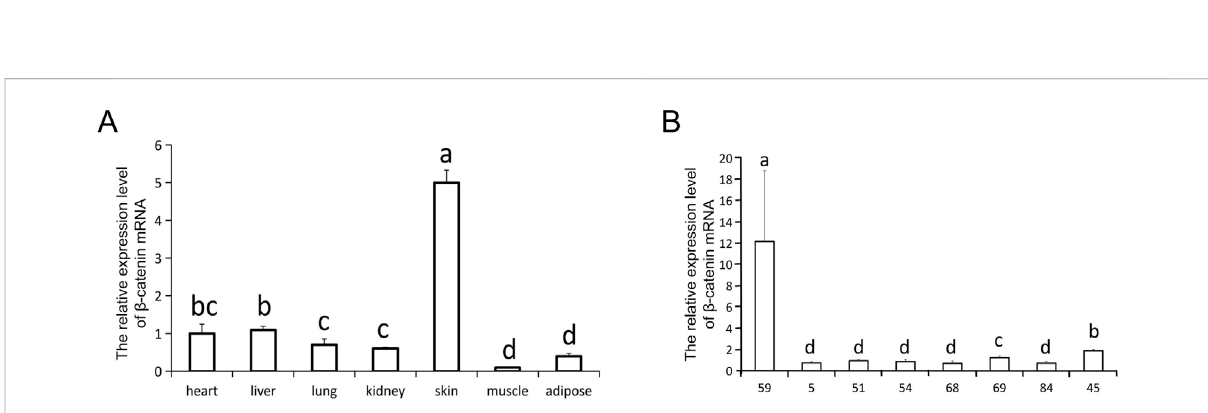
FIGURE 2 The relative expression level of β -catenin mRNA. (A) The expression of β -catenin mRNA in skin of different transgenic mouse lines (F0). 45 is a wilde-type control line. (B) qRT-PCR analysis of the β -catenin mRNA expression in different tissues of line 59 (F0). The relative quantity of β -catenin mRNA in (A) and (B) were determined via qRT-PCR using 2 − ΔΔ CT method, with GAPDH as the internal control. Each experimental group contained threereplicatesandqRT-PCRwasperformedintriplicate for eachsample. Bars withcommonlowercaseletters had nosigni fi cantdifferenceat the 5%